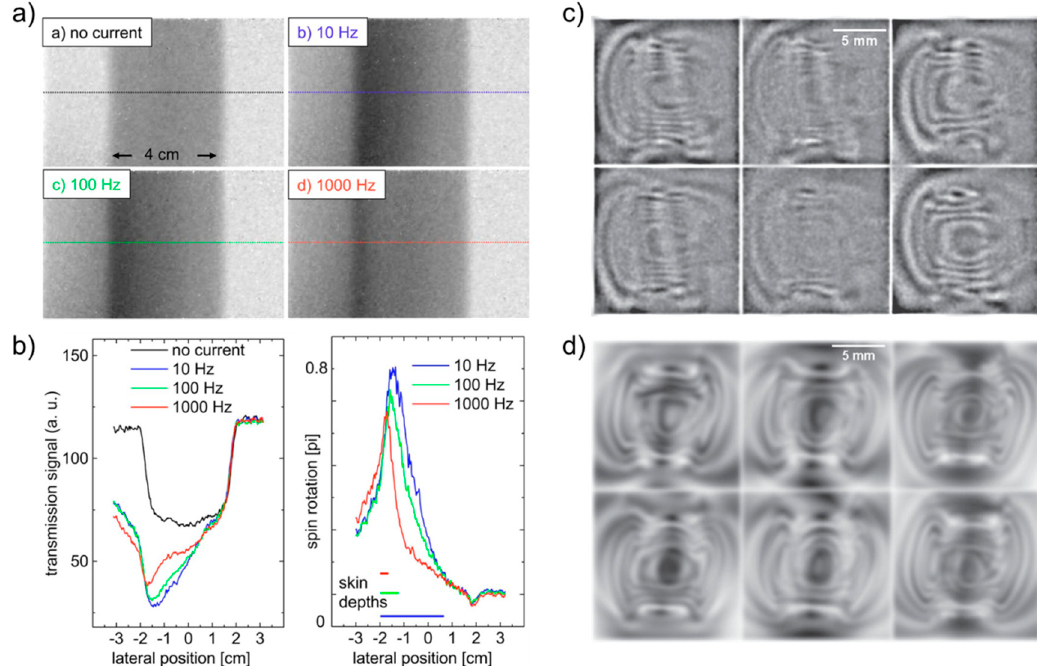
Figure 2. ( a ) Observation of skin effect in a bulk aluminum sample of 4 cm diameter without applied current and with 25 A alternating current at 10 Hz, 100 Hz, and 1000 Hz; ( b ) Analysis of the spin-polarized image data shows an inhomogeneous magnetic field distribution that can be related to a current distribution similar to this observed in the experiment. The current flows close to the surface of the conductor at high AC frequencies (1 kHz) which is a proof that the skin effect is observed (Reprinted from [10], with the permission of AIP Publishing); ( c ) Spin-polarized neutron image of magnetic field produced by a 15-loop coil running at 3 kHz current with 10 A rms amplitude measured in a polychromatic neutron beam. The time slice interval of the shown images is 10 µs; ( d ) Simulations performed based on experimental parameters [11].